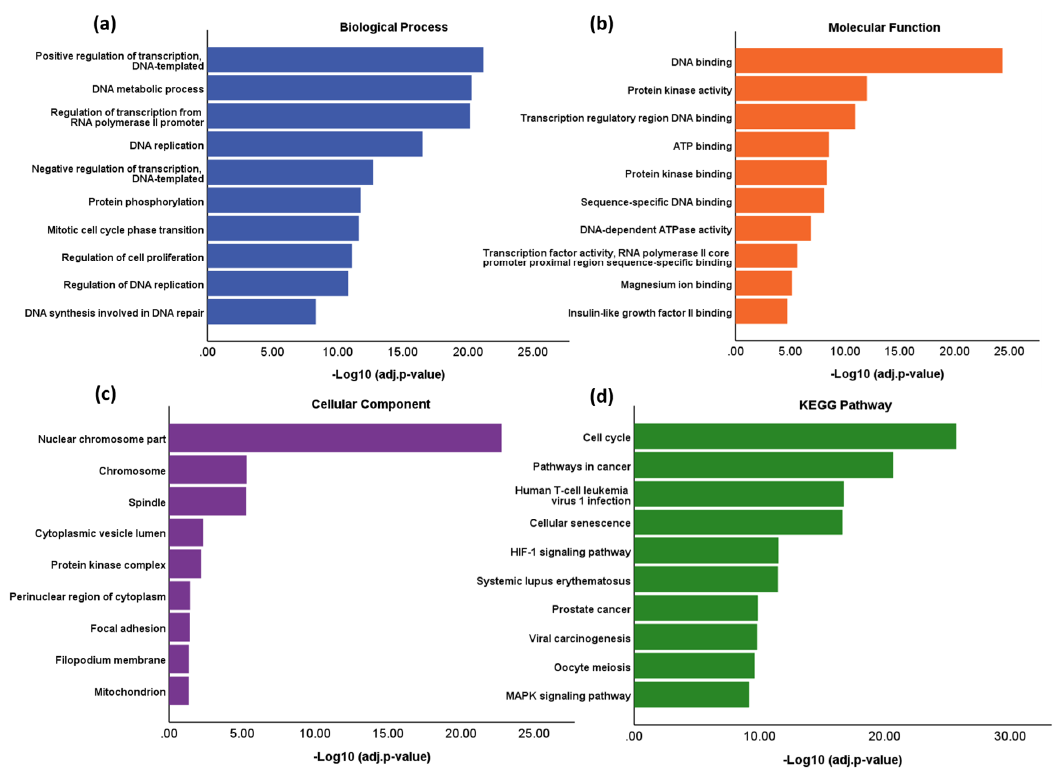
Figure 6. Functional Enrichment and Pathway Analysis of DEGs. GO terms and Kyoto Gene and Genome Encyclopaedia (KEGG) pathways were identified using Enrichr. The GO terms were subsequently revised into a smaller representative list using REVIGO (similarity < 0.5). ( a ) Biological Process. ( b ) Molecular Function. ( c ) Cellular Component. ( d ) KEGG pathway. Methods Protoc. 2020 , 3 , x FOR PEER REVIEW